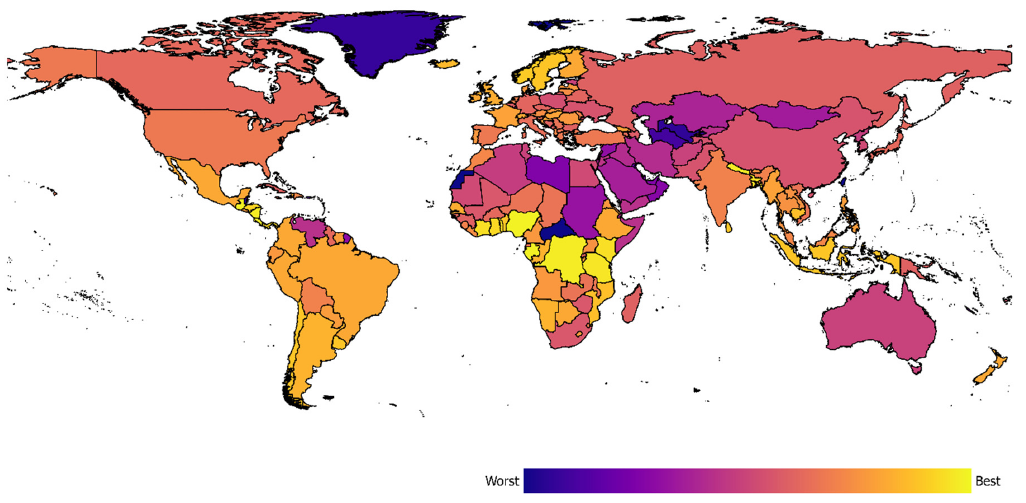
Figure 10. Global view on the environment dimension.